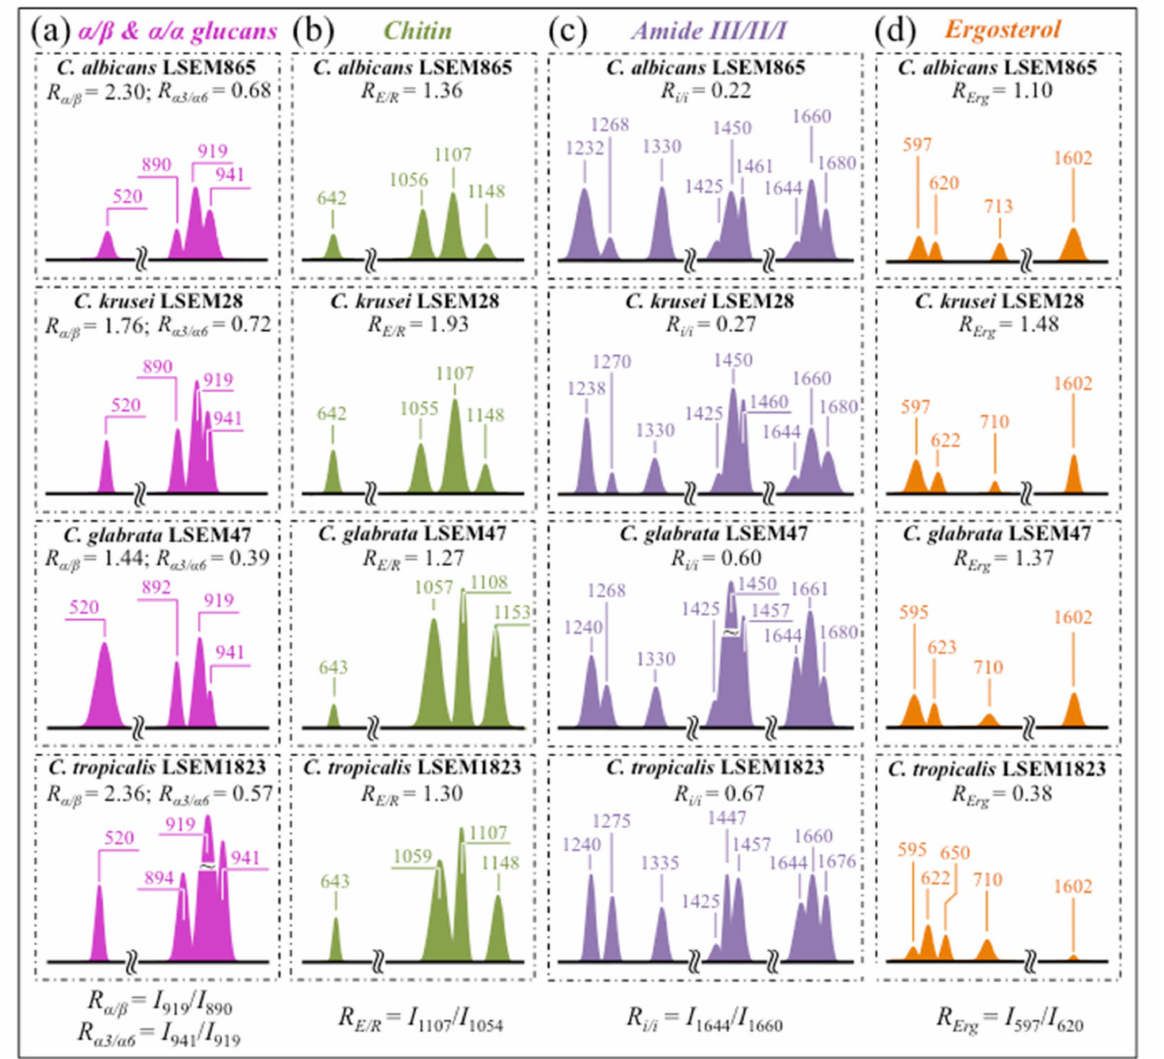
Figure 3. Diagrams drawn to summarize the spectroscopic differences recorded between different C. auris species (cf. labels); the sub-band components discussed in the text as markers of specific molecules are redrawn and compared with respect to their normalized intensities and wavenumber positions: ( a ) glucans; ( b ) chitin; ( c ) Amides I, II, and III, and ( d )